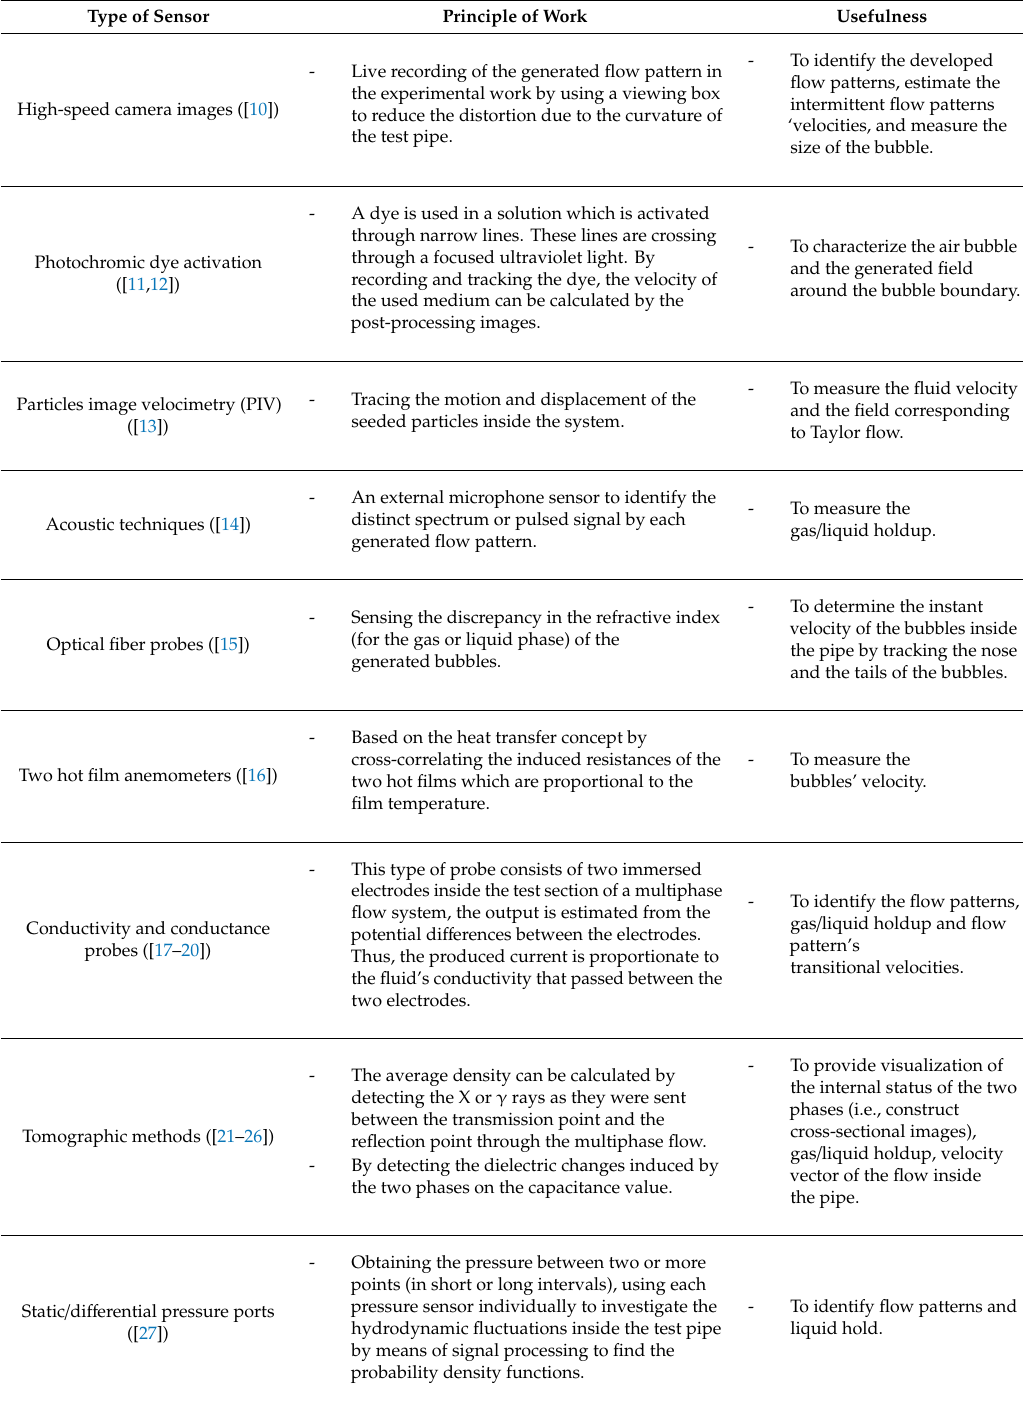
Table 1. A summary of the commonly utilized sensors and measurement devices in a multiphase gas–liquid